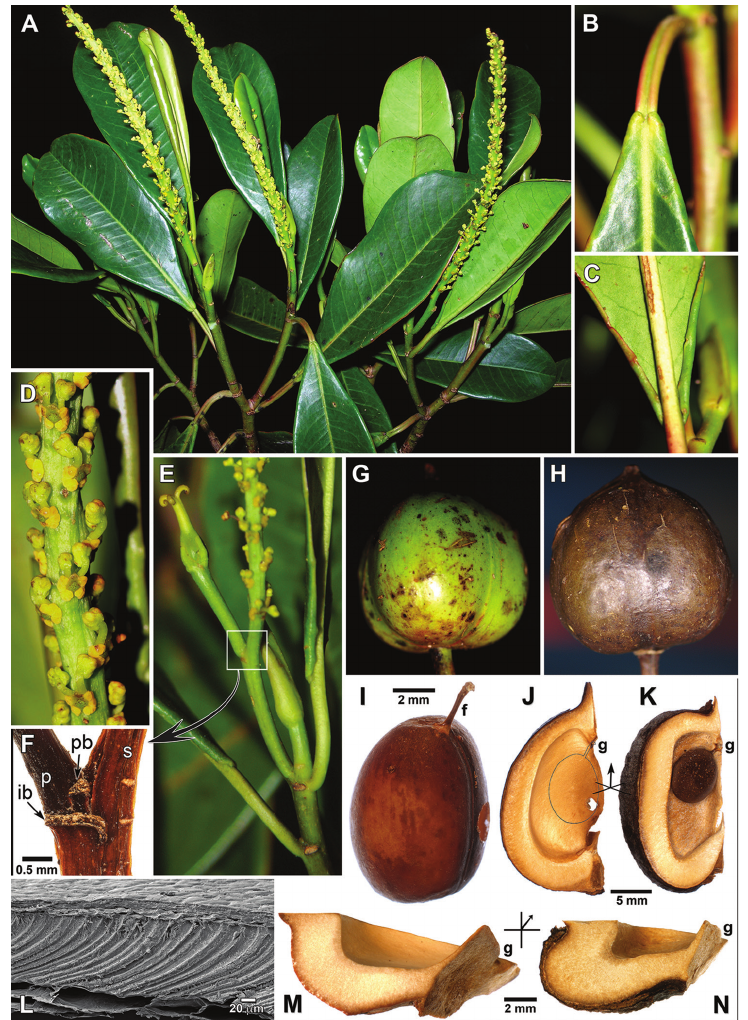
Figure 3. Morphology of Incadendron ( A–J, L–M ) and Senefelderopsis ( K, N ). A Habit, with paired branching and staminate inflorescences; note latex at damaged nodes B Leaf base (adaxial) with basal lobes C Leaf base (abaxial) with curled glandular margin D Staminate inflorescence with cymules sub- tended by glands; central flowers abscised leaving two lateral buds per cymule E Branch tip showing leaf-opposed inflorescence and stipule-enclosed renewal shoot F Summit of peduncle showing bract scars G Nearly mature green fruit H Mature brown fruit I Seed with funicle; holes in I & J come from insect predation J Mericarp valve with outline of seed position K Mericarp valve with a seed; funicle obscures gap L Seed coat, transverse view (SEM) M Pericarp profile and top half of valve (exocarp removed) N Pericarp profile and top half of valve. (Abbreviations: f = funicle, g = gap, ib = inflorescence bract scar, p = pistillate, pb = pistillate bract scar, s = staminate. Orientation of M–N relative to J–K shown by diagrams where x-y = plane of cross section, z = apically pointing arrow. (Source: Incadendron , A–E, G–H Farfan et al. 1049 , 1131 ; F Farfan et al. 706 , MO; I–J, M Monteagudo & Ortiz 4605 , US; L Monteagudo et al. 4484 , US. Senefelderopsis croizatii , K, N Radosavljevic 296 ,